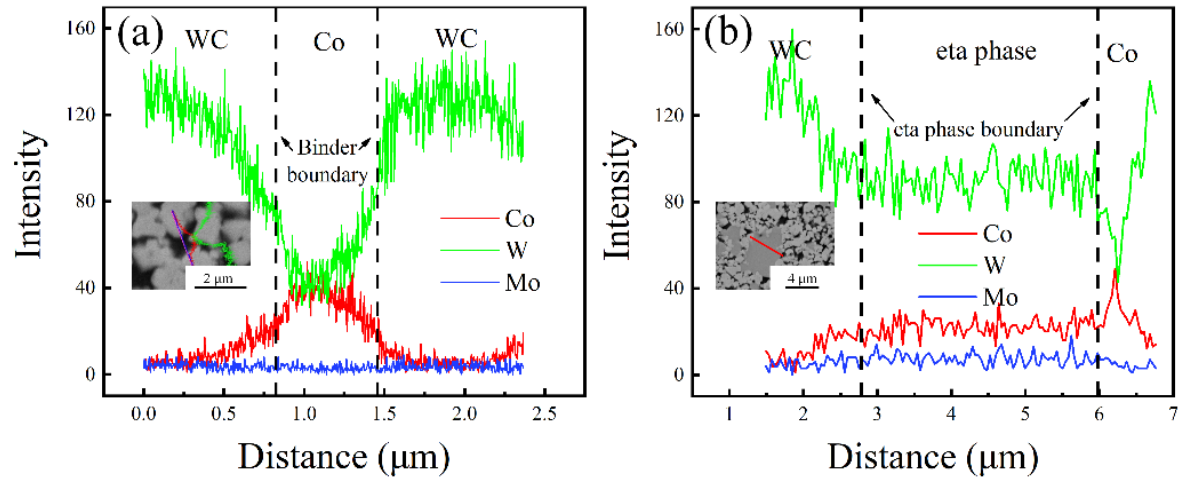
Figure 8. Elements distribution of ( a ) Co phase and ( b ) eta phase in the 2.5Mo-5.0C sample.